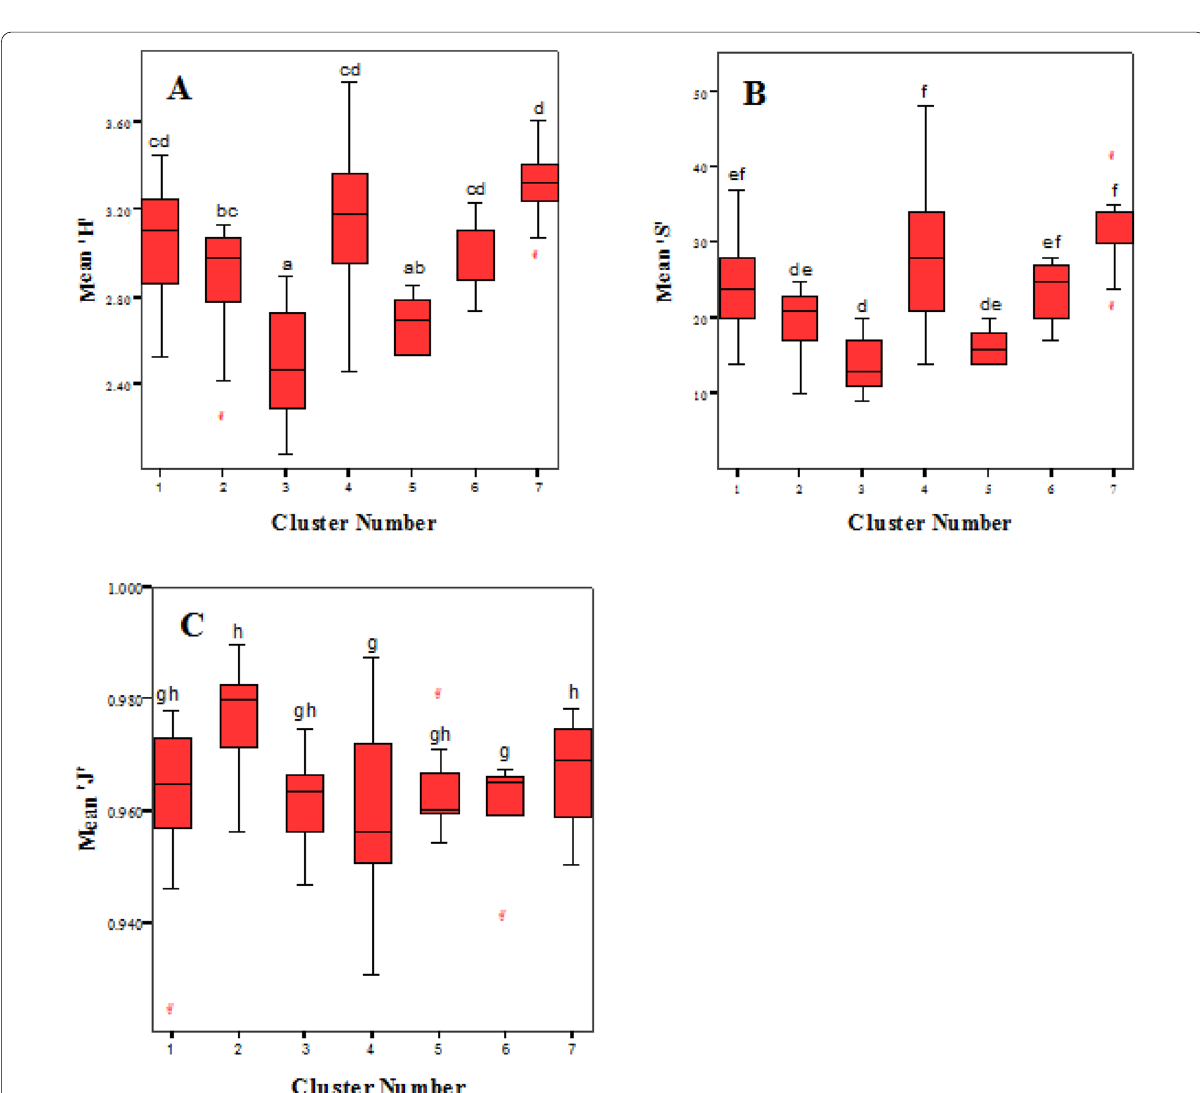
Fig. 8 Mean values of plant diversity per plot for the different clusters in the study area. A Variation of mean species diversity. B Variation of mean species richness. C Variation of mean species evenness between the clusters. Boxes represented by the same letters are not significantly different at P < 0.05